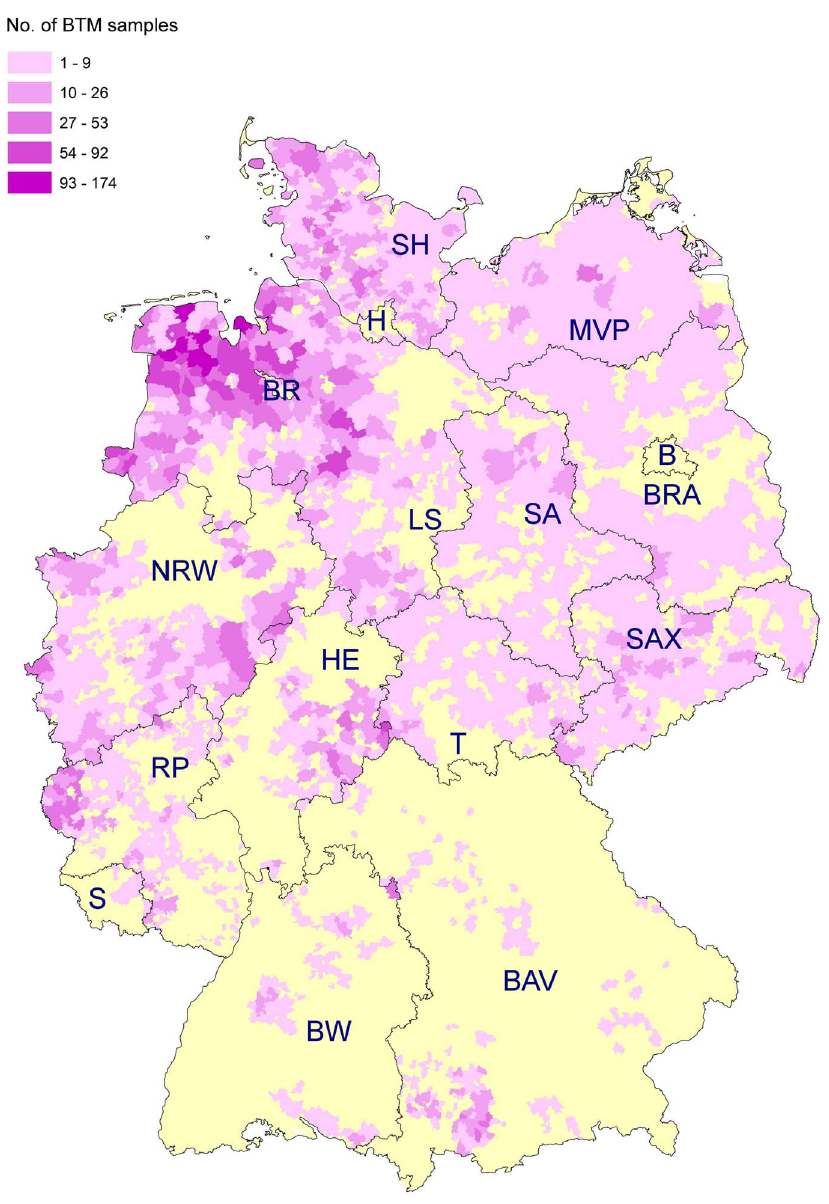
Figure 1. Map of Germany illustrating the number of examined BTM-samples per postal code district. The yellow colour marks postal code districts which were not sampled. Federal states are abbreviated as follows: B=Berlin, BAV=Bavaria, BR=Bremen; BRA=Brandenburg, BW=Baden-Wu¨rttemberg, H=Hamburg, HE=Hesse, LS=Lower Saxony, MWP=Mecklenburg-Western Pomerania, NRW=North Rhine-Westphalia, RP=Rhineland-Palatinate, S=Saarland, SA=Saxony-Anhalt, SAX=Saxony, SH=Schleswig-Holstein, T=Thuringia.